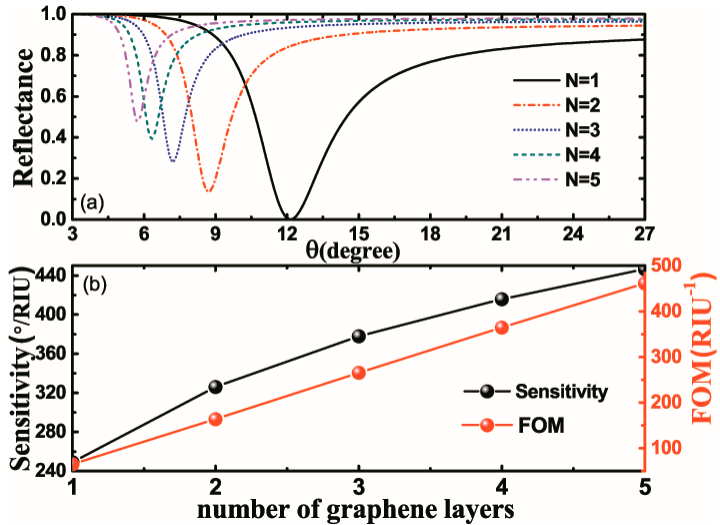
Figure 6. ( a ) Reflectance of the proposed structure with respect to incident angle at d s = 390 µ m. ( b ) Variations of sensitivity with respect to the thickness of the sensing medium. ( c ) Sensitivity of the proposed structure as a function of the refractive index of the sensing medium.